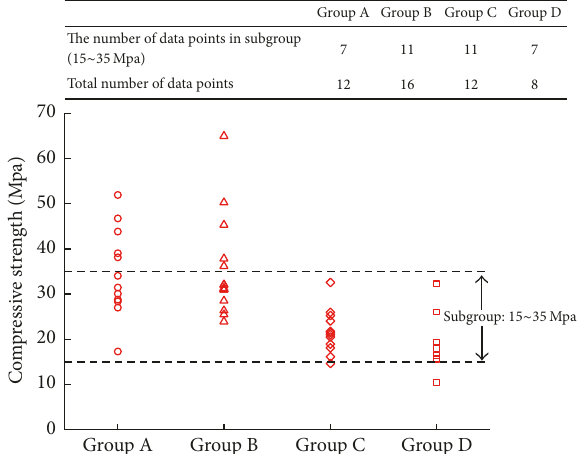
Figure 8: The predicted compressive and tensile